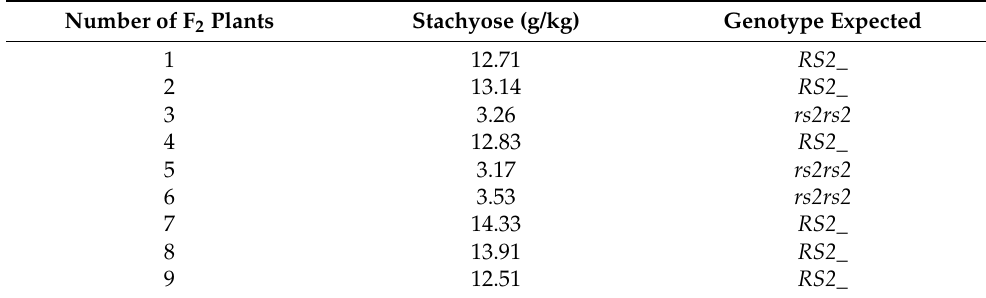
Table 3. Content of stachyose for nine F 2 plants (F 3 seeds) with the triple null allele ( lox1lox2lox3 / lox1lox2lox3 - ti / ti - le / le